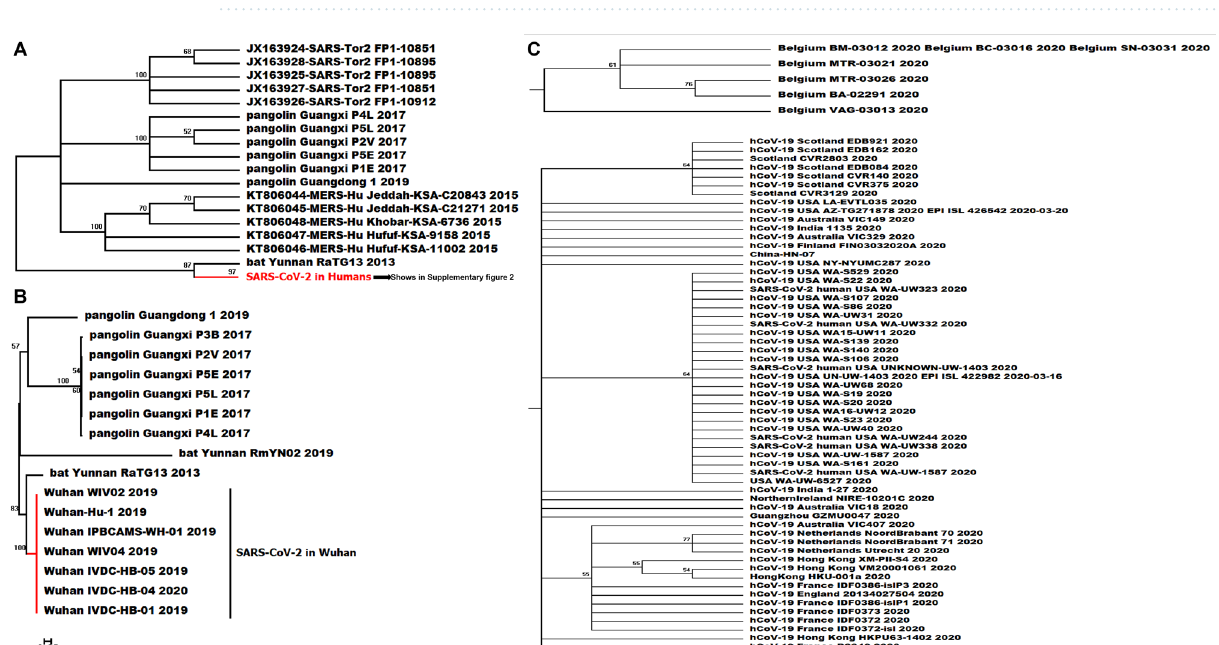
Figure 3. Phylogenetic tree based on S gene (Partial, the complete tree was found in Supplementary Fig. S2), the bootstrap values were mapped on the branch as long as the colors annotated for all clades ( A ) The phylogenetic relationship of SARS-CoV, MERS-CoV and coronaviruses in pangolin and bat, SARS- CoV-2 in human on the bottom includes branches of SARS-CoV-2 from 164 regions based on S sequences (Supplementary Fig. S2); ( B ) The phylogenetic relationship based on S gene sequences of SARS-CoV-2 collected from Wuhan city of China in the early time of COVID-19 pandemic and beta coronaviruses derived from bat and pangolin; ( C ) Clades of SARS-CoV-2 from the regions show more divergent in S gene along with the COVID-19